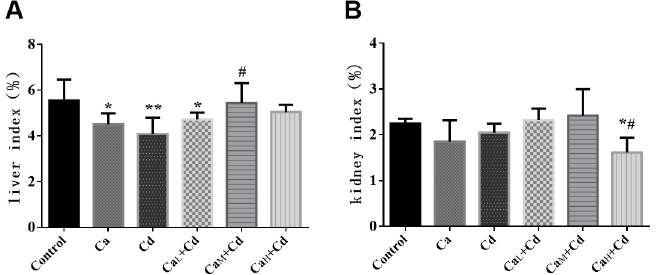
Fig 1. The liver index (A) and kidney index (B) in different groups. The data are shown as mean ± SD. � P < 0.05, compared with control-group. �� P < 0.01, compared with control-group. # P < 0.05, compared with Cd-group. ## P < 0.01, compared with